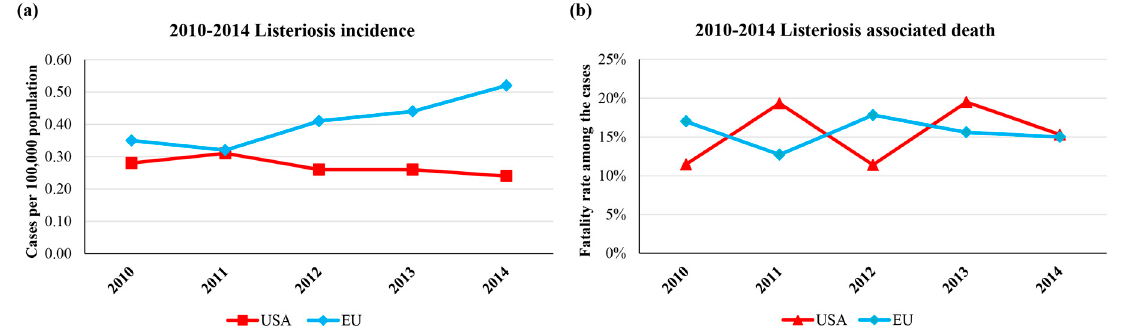
Figure 1. Listeriosis incidence and associated death in the USA and the EU from 2010 to 2014. Panel ( a ) shows the number of cases of listeriosis per 100,000 population; in panel ( b ), the percentage of listeriosis associated death among the confirmed illness cases are reported.